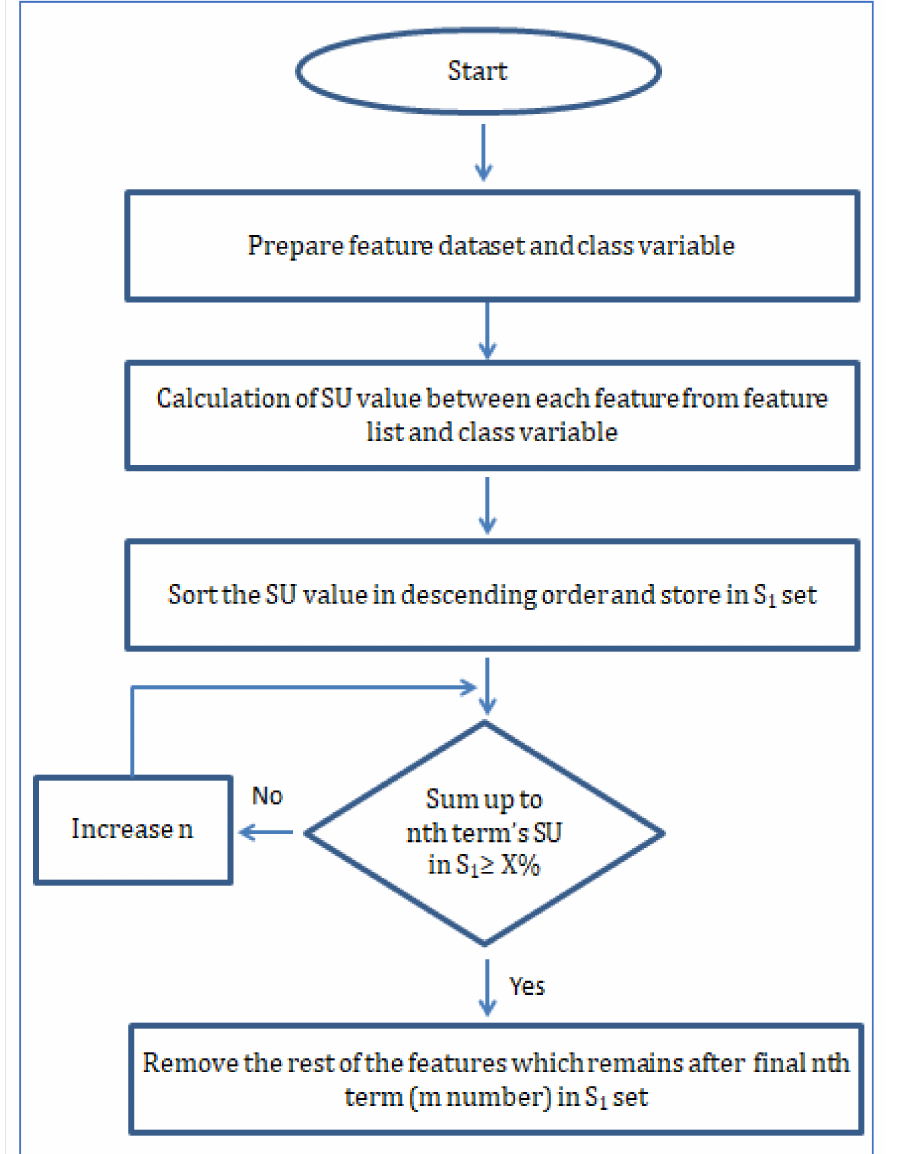
Figure 9. Step 1: Flowchart of fast correlation using SU value to find the relevant feature